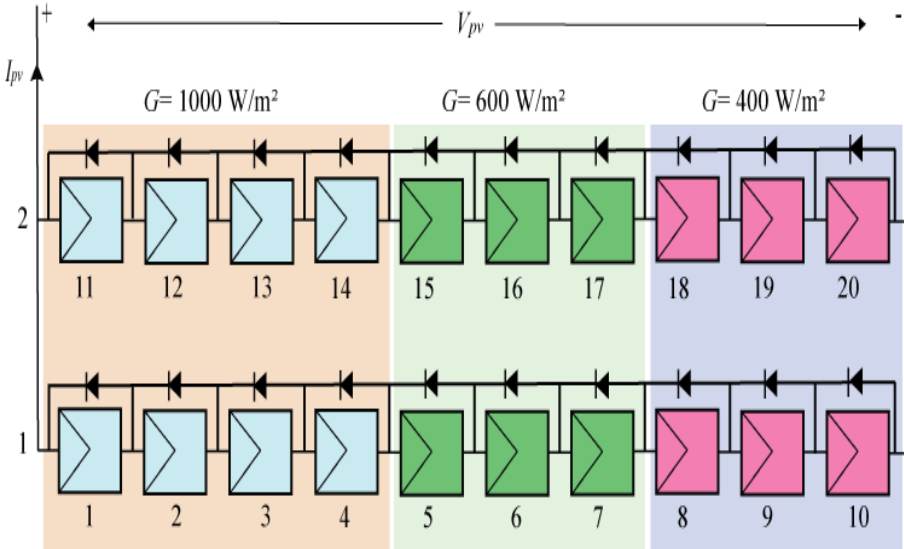
Energies 2022 , 15 , x FOR PEER REVIEW Figure 11. Shading patterns for scenario one. Figure 11. Shading patterns for scenario one.